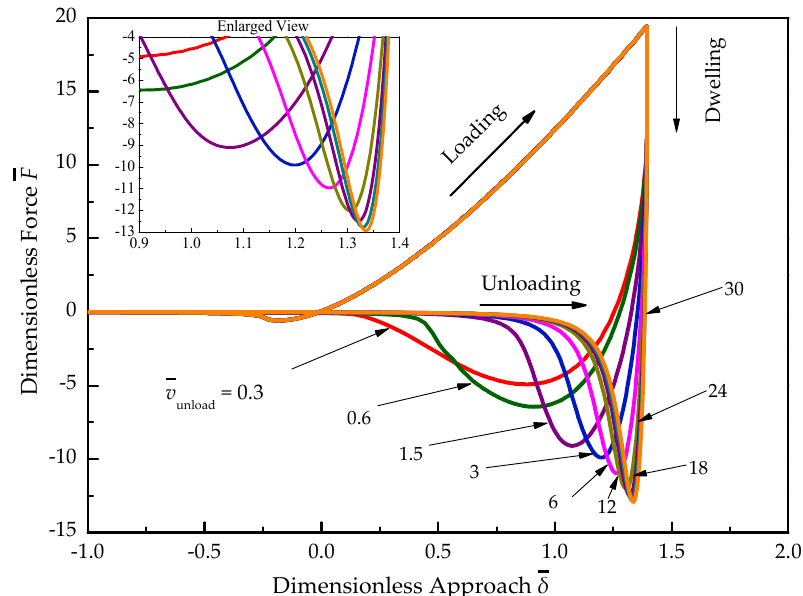
Figure 5. Force-approach curves for different unloading velocities under the condition of ∆ γ = 0.05 and F preload = 19.